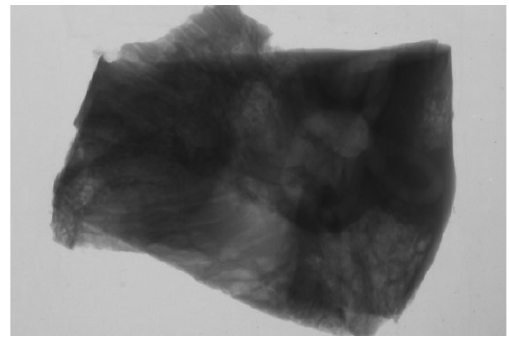
Fig. 1. Example 2D projection image of micro-CT